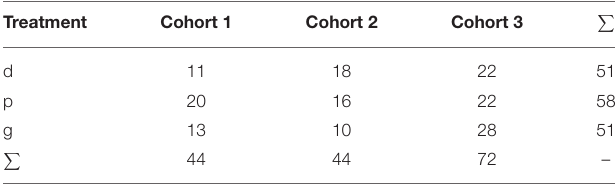
TABLE 1 | Summary of sample